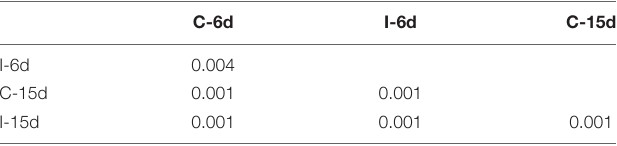
TABLE 2 | AMOVA p -values of treatment groups (permutations = 999).